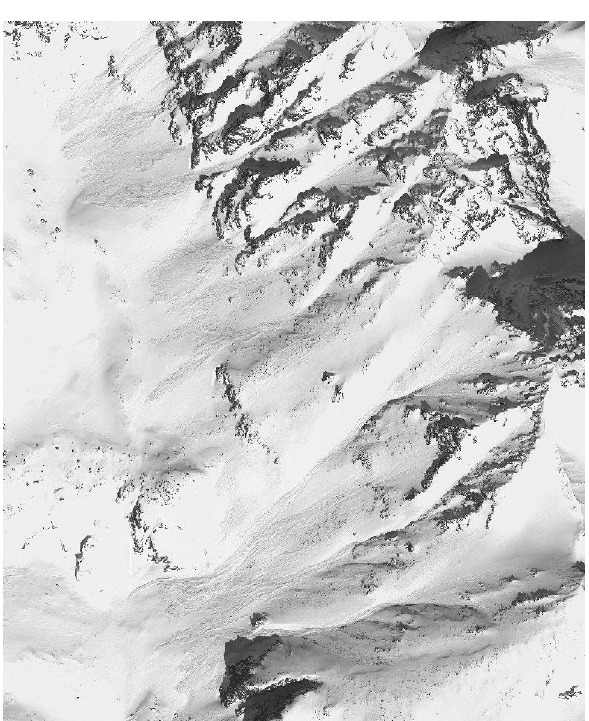
Figure 7a: Qualitative comparison between expert mapping and algorithm performance: Raw image. (Satellite image: